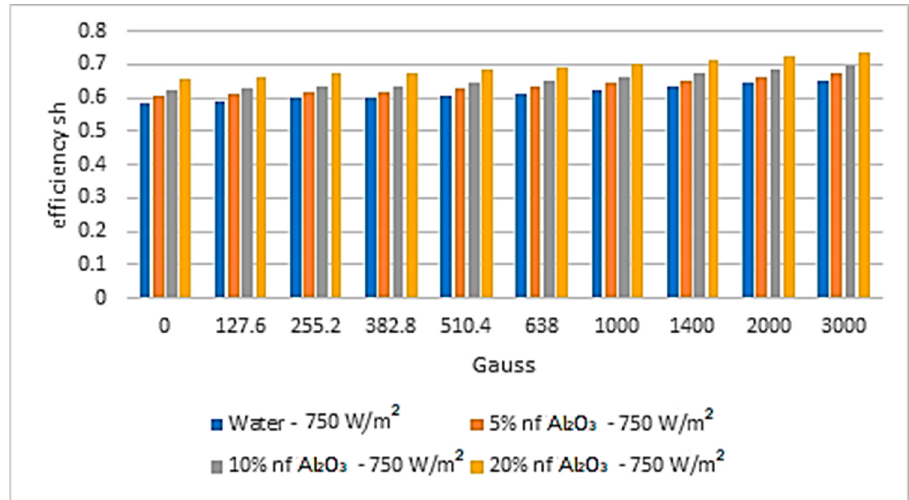
Figure 12. Thermal efficiency of the hybrid system generated by PV-Th solar panels with different magnetic fields.